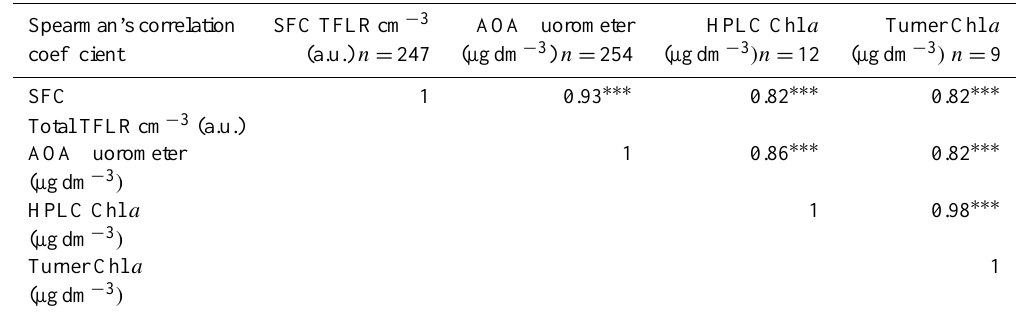
Table 2. Spearman’s rank correlation coefficient between the different methods used for chlorophyll a estimates and with the total TFLR from the scanning flow cytometer per unit volume.